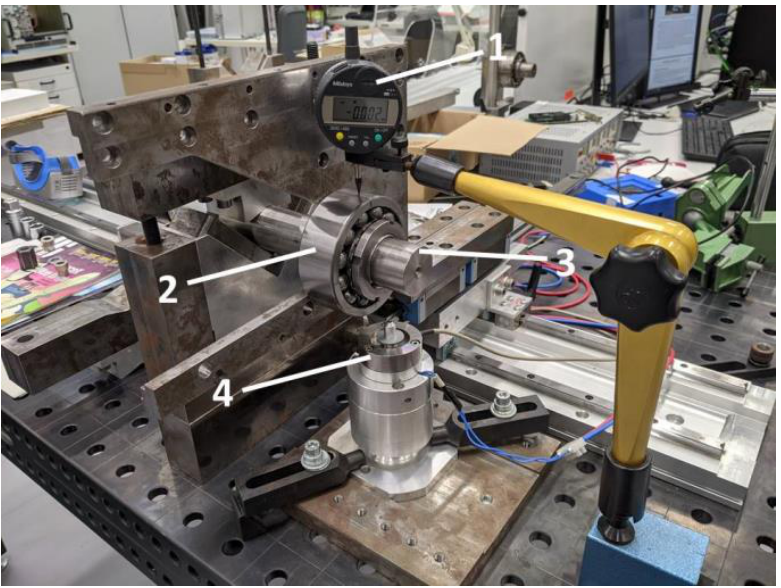
Figure 7. Automated system with the automated radial internal clearance measurement after mounting with the studied bearing NTN 2309SK. 1—Dial gauge, 2—Seated bearing, 3—Shaft, 4—Electromagnetic actuator and holder.